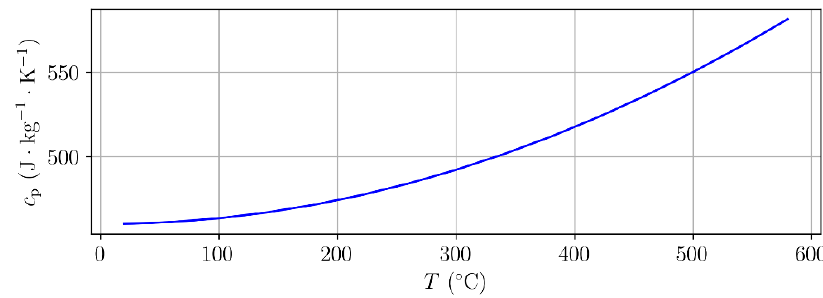
Figure 5. Temperature dependence of specific heat capacity (powder H13). Metals 2021 , 11 , x FOR PEER REVIEW